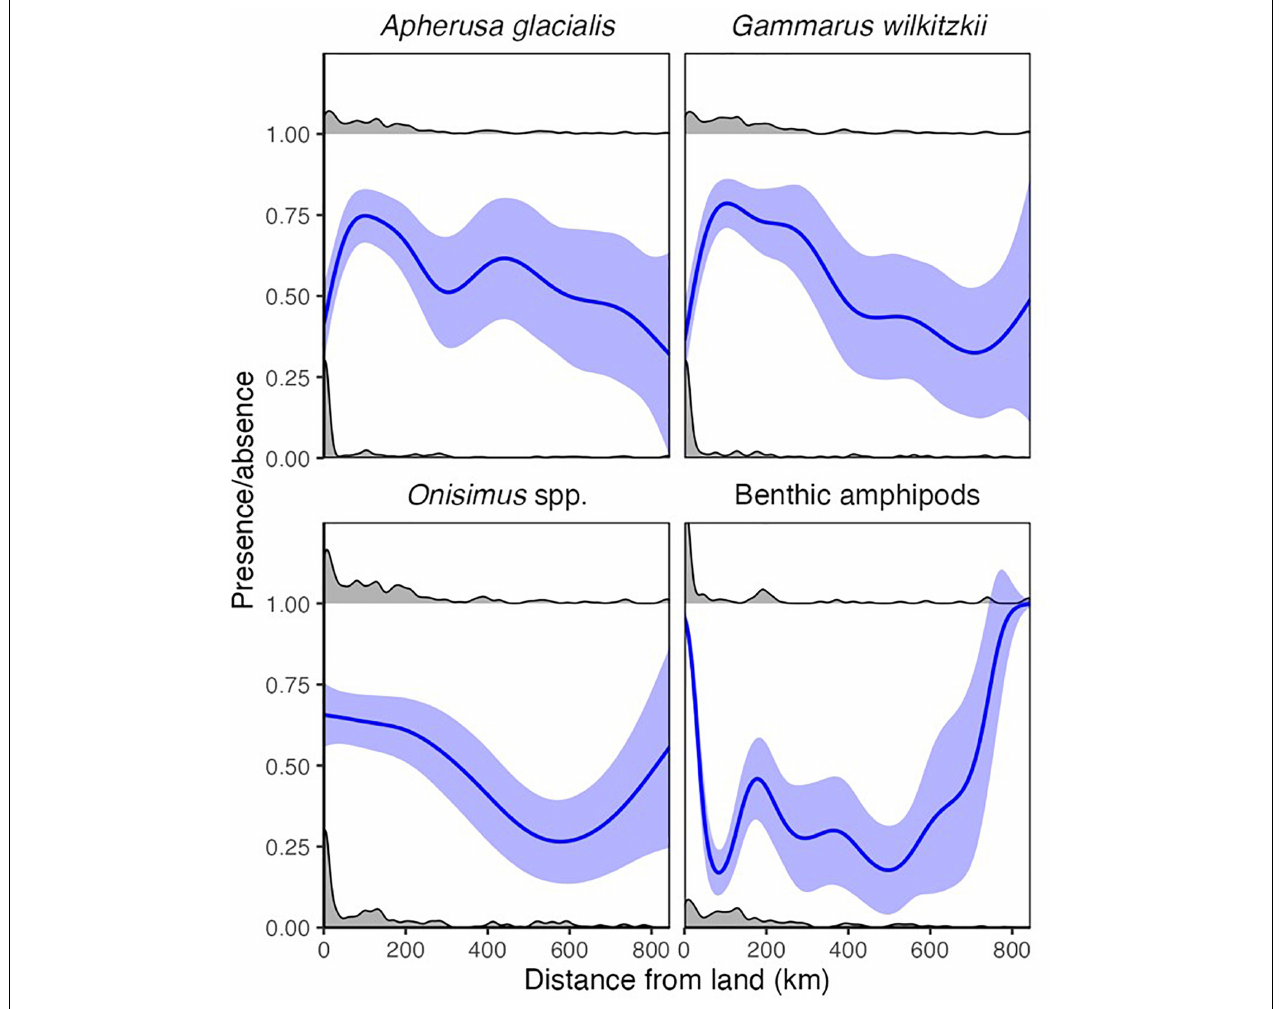
FIGURE 6 | Distance from land for binary (occurrence) data. The lines represent binomial GAMM models for each species. The gray density distributions indicate presences (1) and absences